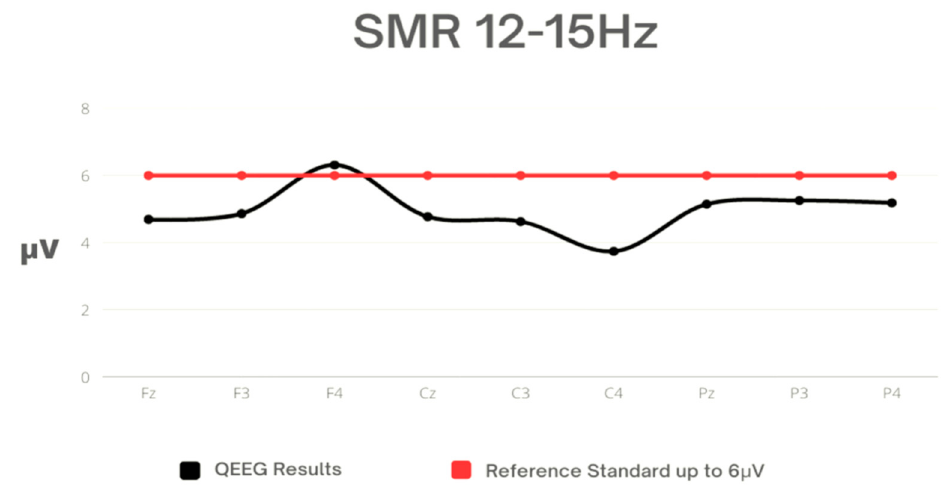
Figure 4. Mean values for SMR against the reference standard. Table 6. Descriptive statistics for Beta waves from all channels ( µ V).